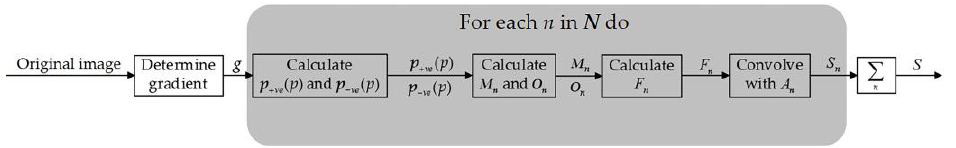
Figure 5. Schematic diagram of FRST.